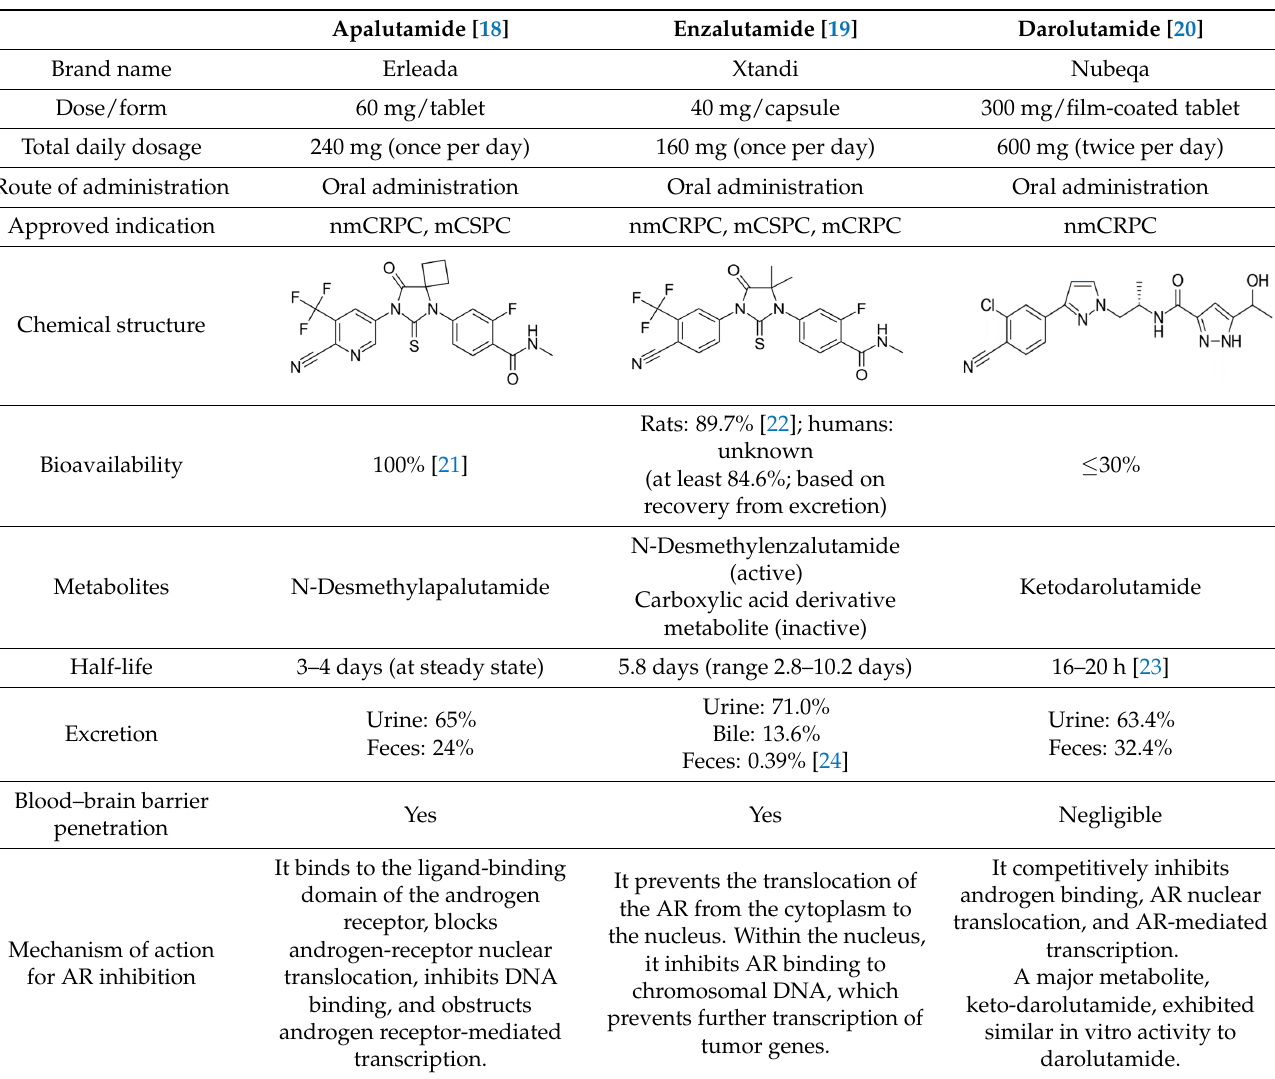
Table 1. Comparison of basic characteristics for second-generation AR inhibitors.